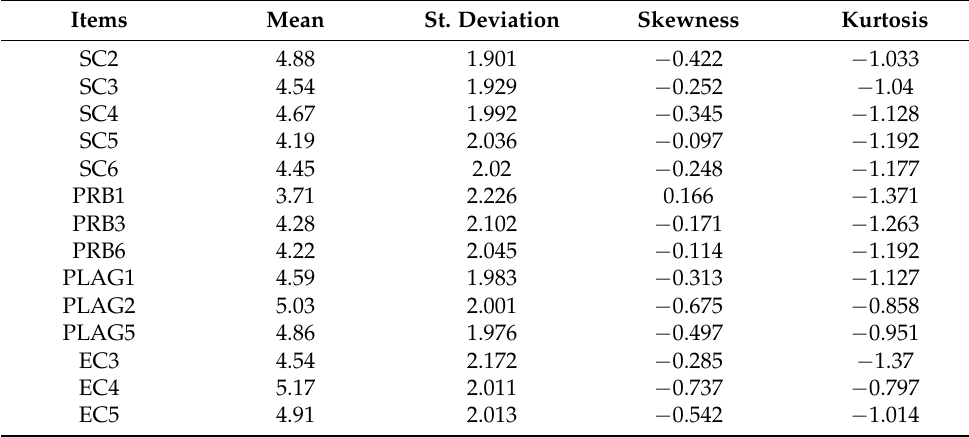
Table 5. Descriptive statistics of the final items.